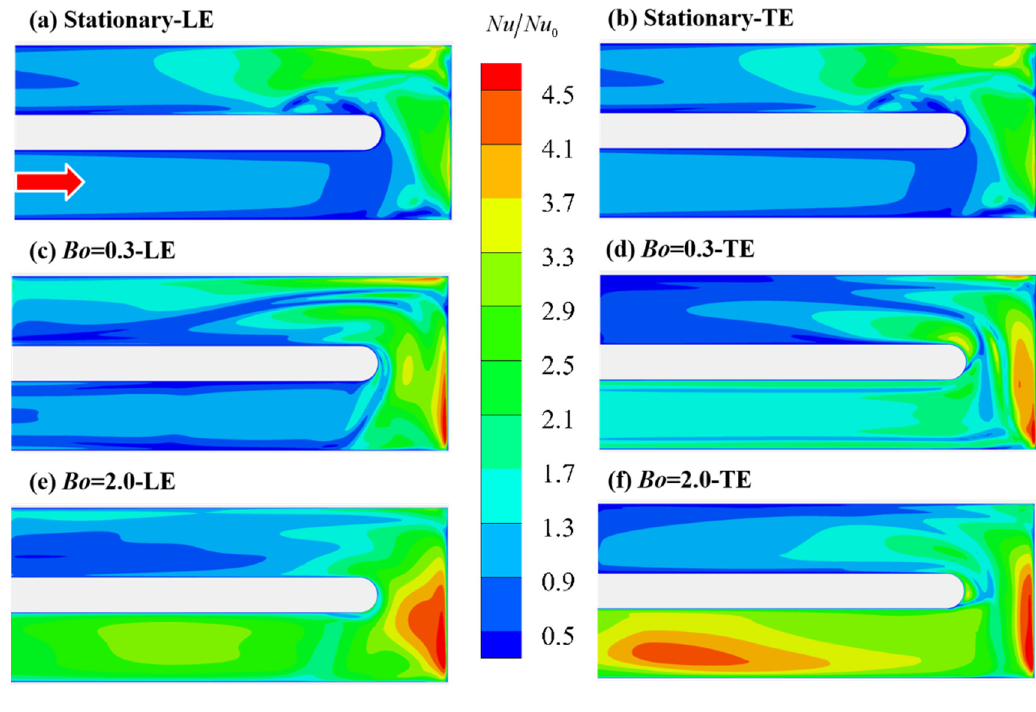
Figure 13. Nu / Nu 0 contour of smooth channel.